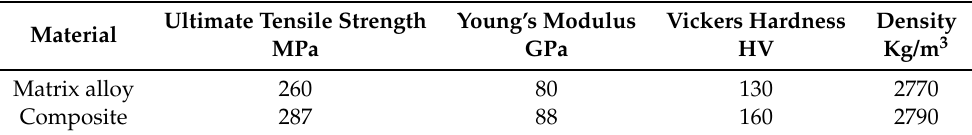
Table 2. Material properties of Al–12Si–CuNiMg matrix alloy and Al 2 O 3 fiber-reinforced composite.